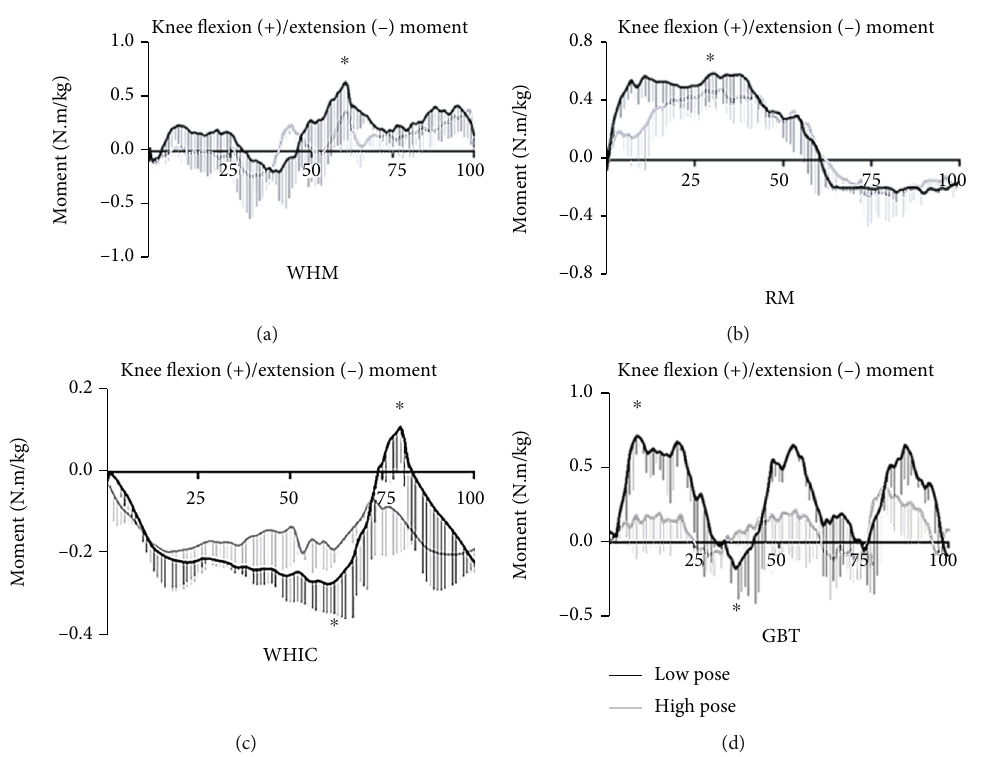
Figure 3: Joint moment at knee in sagittal plane in high (black) and low (gray) pose for wild horse ’ s mane (WHM), repulse monkey (RM), wave-hand in cloud (WHIC), and grasp the bird ’ s tail (GBT) during one support phase ( N = 14 ). ∗ p < 0 : 05